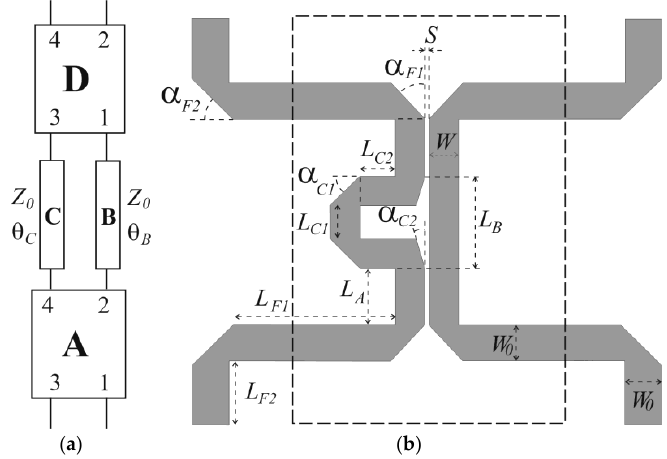
Figure 2. Structure of the proposed coupler: ( a ) Circuital model; ( b ) Microstrip realization, including test ports (dashed box shows the actual coupler size).